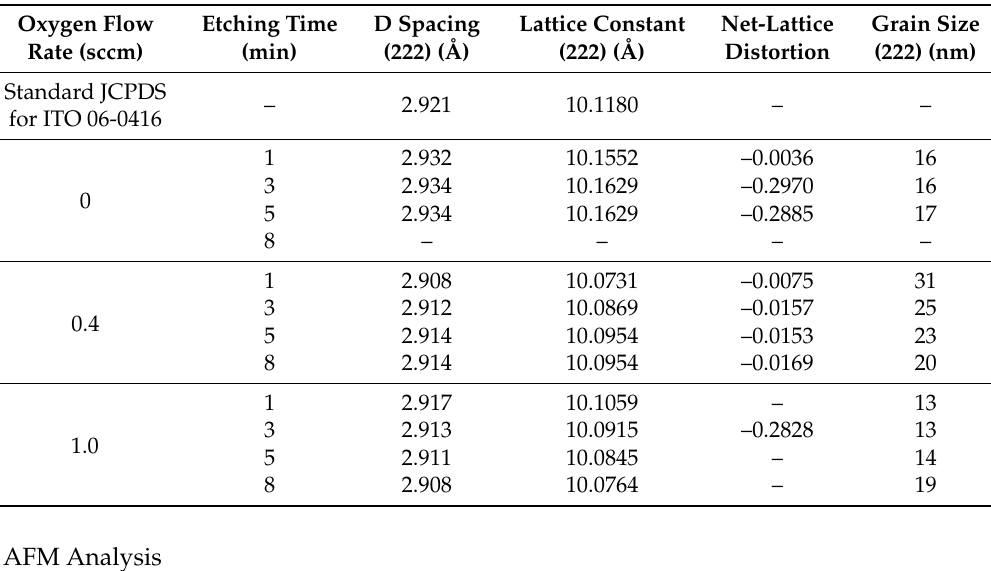
Table 1. Structural parameters of ITO sputtered films with 0, 0.4 and 1.0 sccm oxygen and etched at 1, 3, 5 and 8 min.